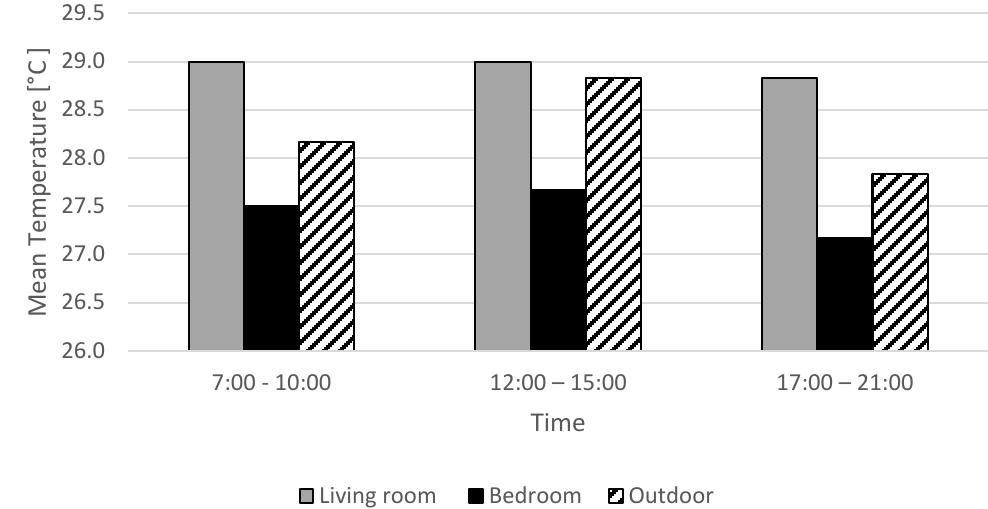
Figure 9. Temperature in the living room, bedroom, and outdoors as averaged over six days of measurements (HRB2).